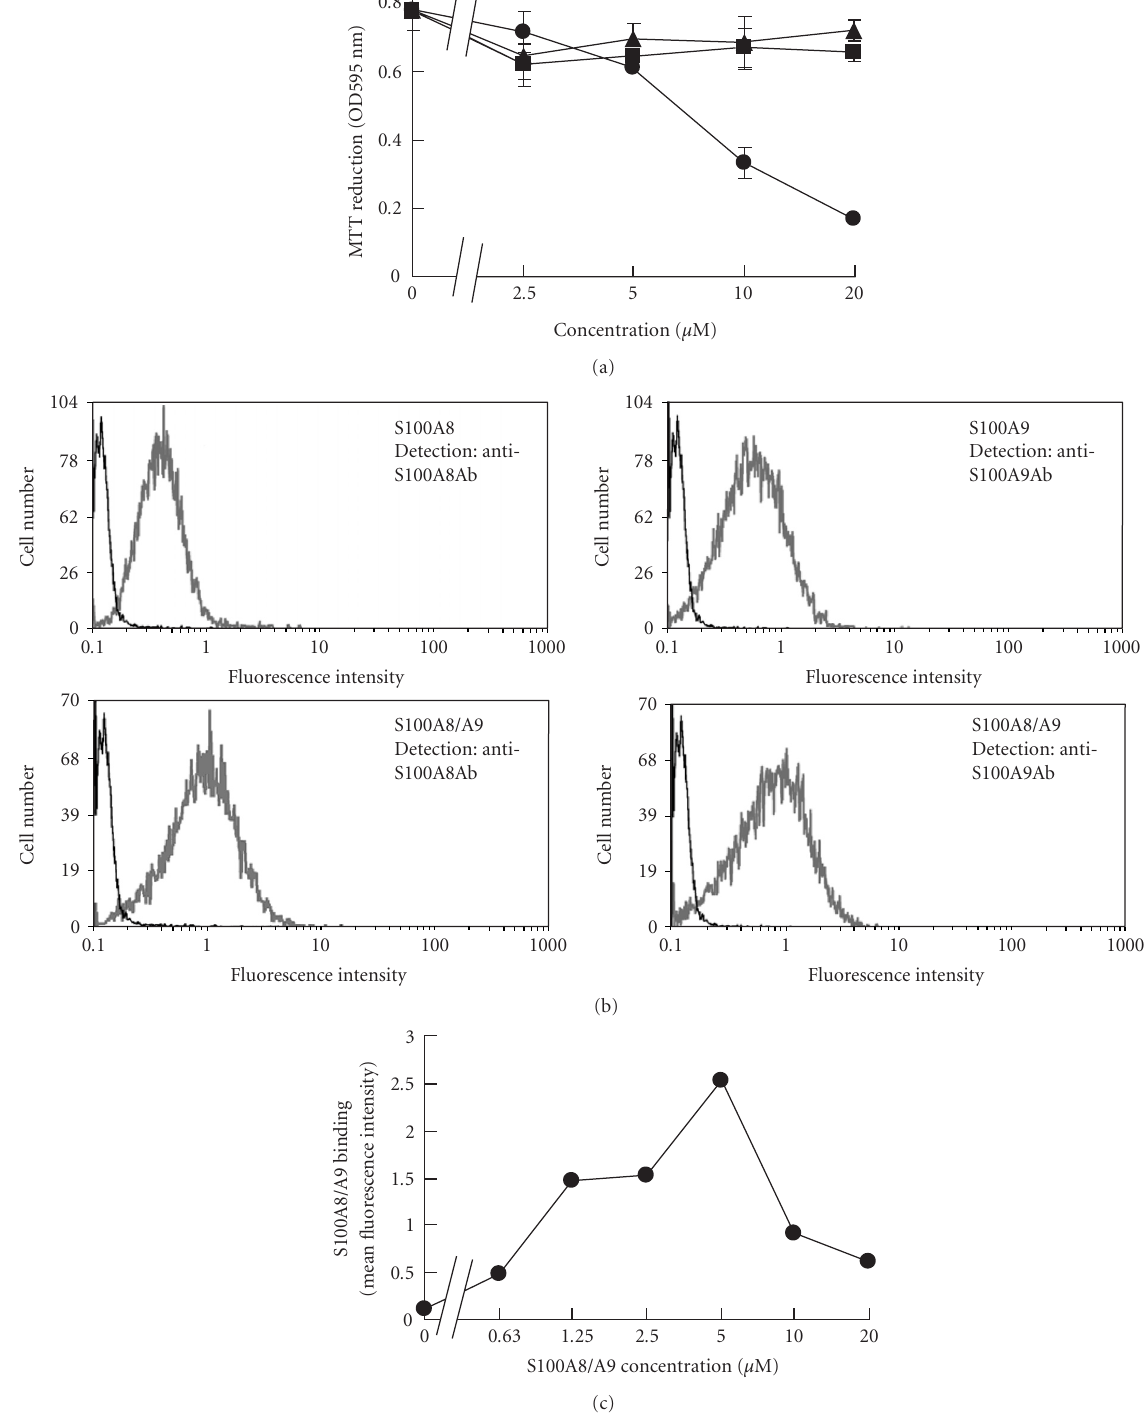
Figure 3. (a) Apoptosis-inducing activity of S100A8, S100A9, and S100A8/A9 against MM46 cells. Cells were cultured with di ff erent • concentrations of S100A8/A9 complex ( ), S100A8 ( (cid:1) ), or S100A9 ( (cid:2) ) for 24 hours. Cell viability was estimated by MTT assay. Bars represent standard deviation. (b) Binding profile of S100A8/A9 complex, S100A8, or S100A9 to MM46 cells. The cells were incubated with (gray line) or without (black line) 5 µ M S100A8, 5 µ M S100A9, or 5 µ M S100A8/A9 for 1 h, respectively. After the incubation, the cells were washed and treated with anti-S100A8 antibody or anti-S100A9 antibody, followed by FITC-conjugated anti-mouse IgG antibody, and analyzed as described in “materials and methods.” (c) Dose-response relationship of the binding of S100A8/A9. MM46 cells were incubated with the indicated concentrations of S100A8/A9 for 1h and the binding is expressed as the geometric mean fluorescence intensity of 10 000